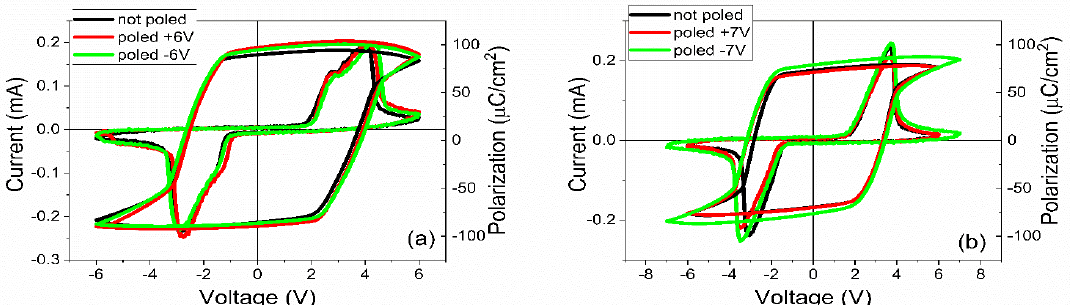
Figure 4. Hysteresis loop obtained at 300 K for the PZT films deposited from the ( a ) commercial target and ( b ) from the pure target. Measurements were performed using a triangular voltage wave of 1 kHz amplitude.